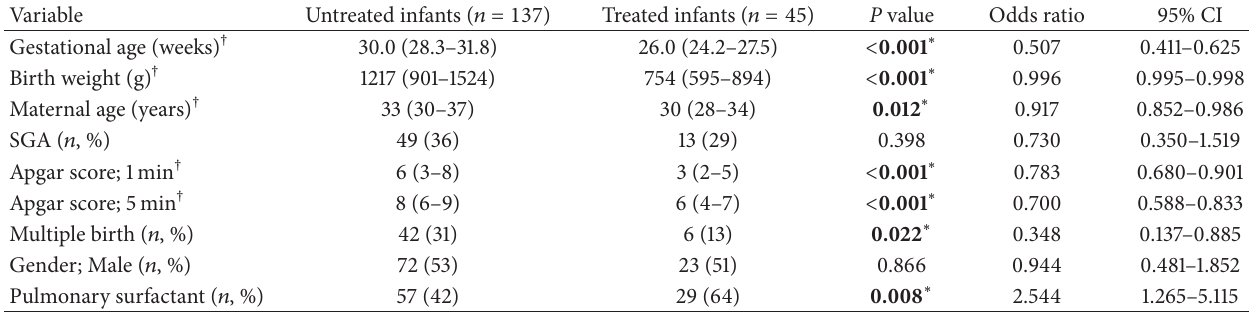
Table 3: Univariate analyses of risk factors for the laser treatment in gestational age < 33 weeks infants. Variable